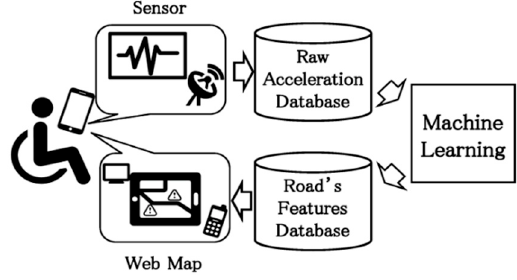
Figure 1. Outline drawing of road surface feature automatic evaluation system by wheelchair sensing and machine learning.